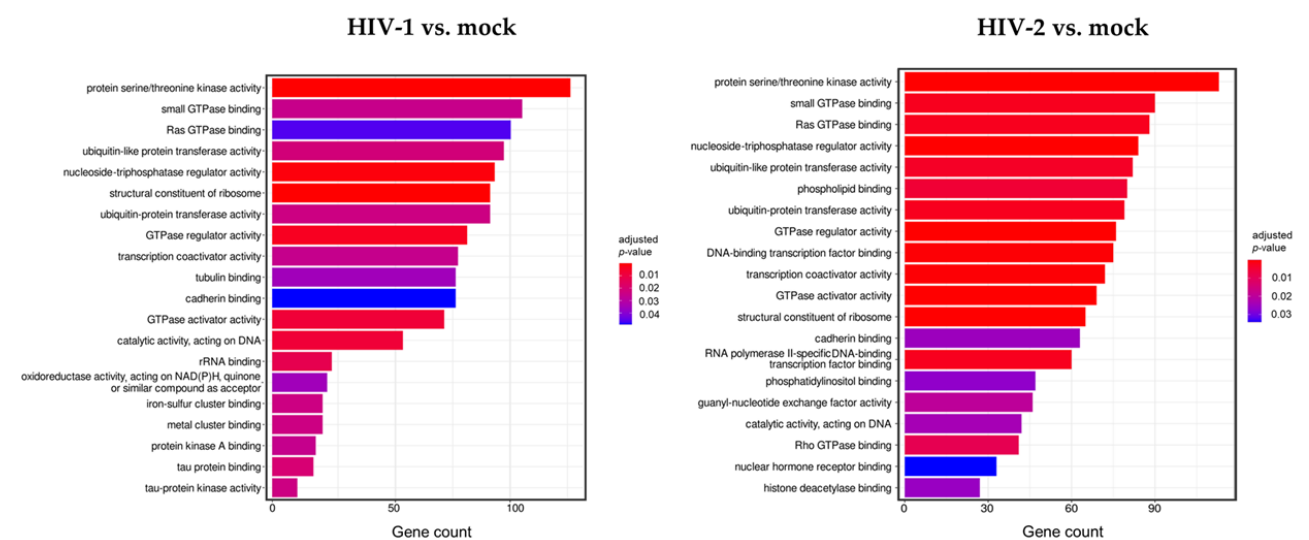
Figure 4. Gene ontology (GO) analysis of differentially expressed genes in HIV-1 ( left panel) and HIV-2 ( right panel) transduced HEK-293T cells at 2 h time-point. Figure shows the classification of top 20 genes according to significant enrichment terms Colour intensity corresponds to the significance of each term. Counts represent the number of differentially expressed genes associated with the listed gene ontology ID.